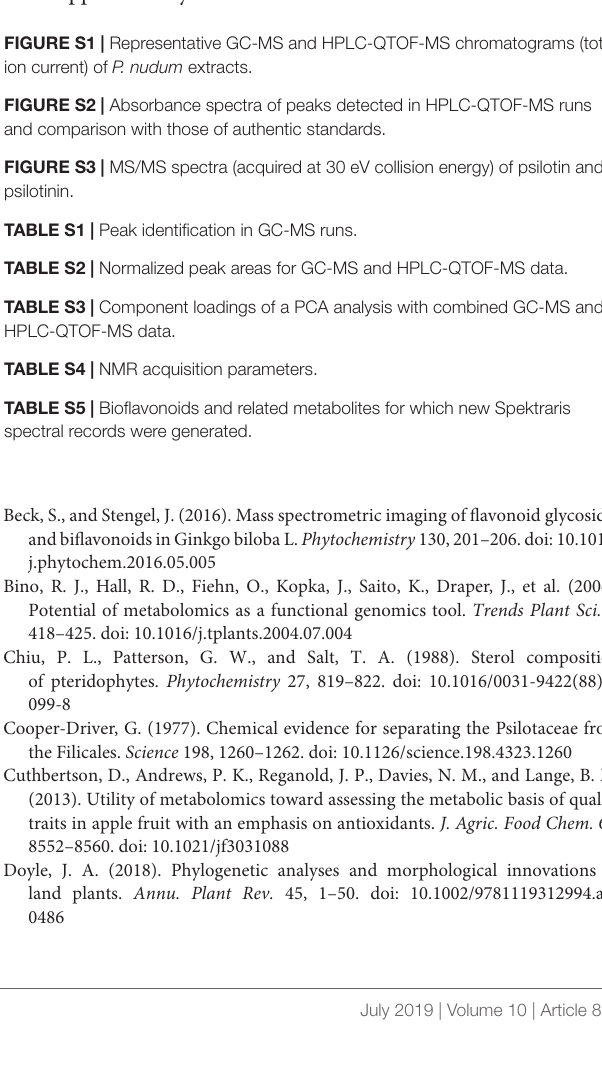
TABLE S1 | Peak identification in GC-MS runs.